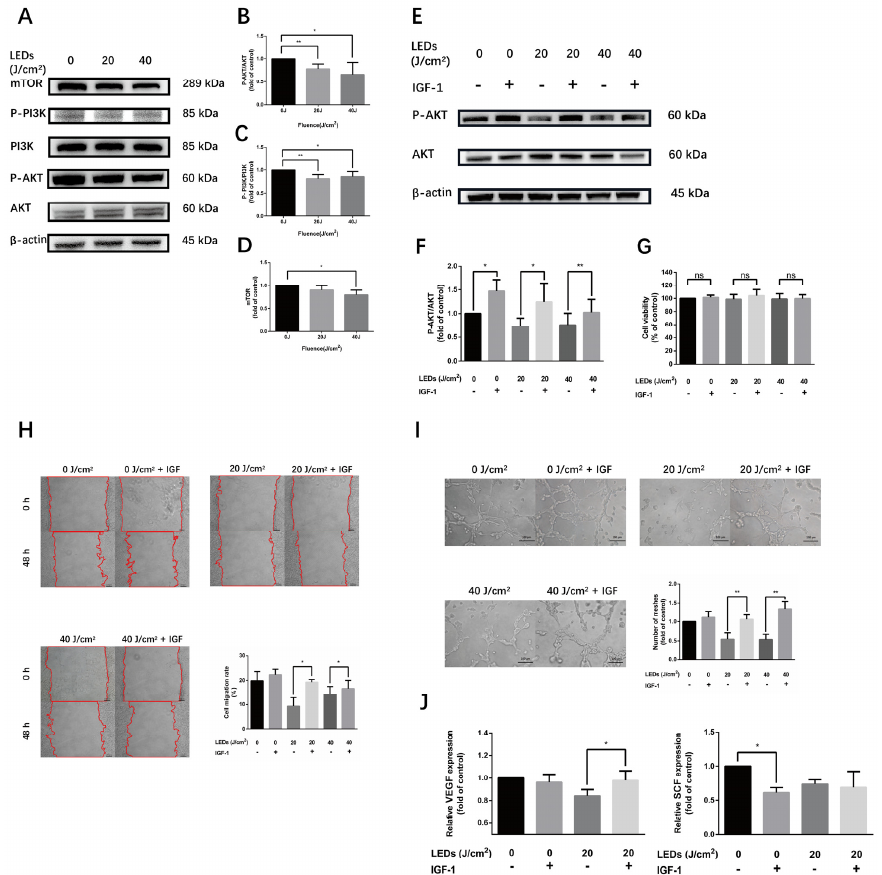
Figure 5. 590 nm LED inhibited angiogenesis of HMEC-1 predominantly via AKT/PI3K/mTOR pathway. ( A – D ) The phosphorylation level of AKT/PI3K/mTOR pathway after LED illumination (20, 40 J/cm 2 , 0.5 h). ( E , F ) The phosphorylation level of AKT after LED irradiation (20, 40 J/cm 2 ) alone or pretreated with IGF-1 (50 ng/mL, 2 h). ( G ) Cell viability of irradiated cells or with IGF-1 pretreatment. ( H ) Cell migration (48 h) of wound healing assay after LED illumination alone or pretreated with IGF-1. Bar, 100 μ m. ( I ) Number of meshes (8 h) of HMEC-1 after LED irradiation alone or with IGF-1 pretreatment. Bar, 100 μ m. ( J ) The secretion of VEGF and SCF from cells irra- diated by 20 J/cm 2 LED alone or with IGF-1 pretreatment detected by ELISA. ( B – D , F , G , I , J ) Results of irradiated groups are normalized to the control. Data are shown as means ± SD. ( A – F ) n = 5; ( G – J ) n = 3. *, p < 0.05; **, p < 0.01. LED, light-emitting diodes; IGF-1, insulin-like growth factor 1; VEGF, vascular endothelial growth factor; SCF, stem cell factor; n.s., no significance.